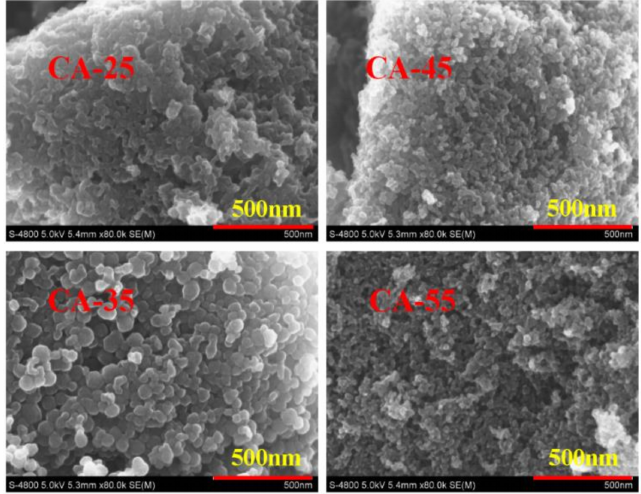
Figure 4. SEM images of CA-X